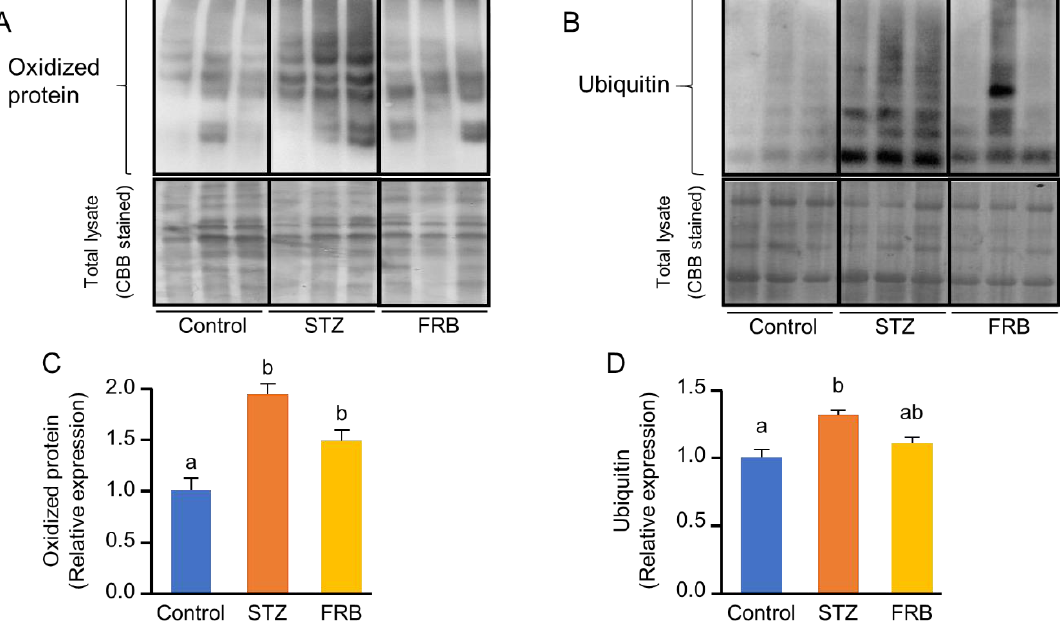
Figure 5. The effect of FRB supplementation on the level of oxidized proteins and ubiquitinated proteins. Representative blots of the ( A ) oxidized proteins and ( B ) ubiquitinated proteins, and the quantification of the ( C ) oxidized proteins and ( D ) ubiquitinated proteins. Data are shown as the means + SEM. Significance ( p < 0.05, n = 5) among groups is denoted by different letters (a, b, ab).